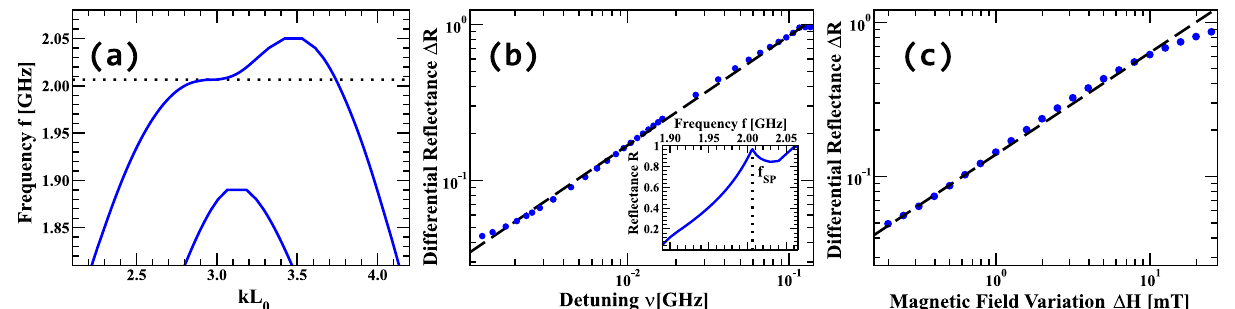
Fig. 2 Full wave simulations of the coupled microstrip waveguide platform. a The dispersion relation of this platform demonstrates a stationary in fl ection point frequency f SP which is shown by a dotted black line. b Logarithmic plot of the differential re fl ectance Δ R (blue dots) as a function of the frequency detuning ν from the non-resonant exceptional point degeneracy frequency f SP . The black dashed line indicates the best fi tting corresponding to a power law Δ R / ν j j 0 : 7 . The inset shows the formation of a cusp in the re fl ectance R spectrum, in the vicinity of f SP (vertical black dashed line). c Logarithmic plot of the differential re fl ectance Δ R (blue dots) as a function of the magnetic fi eld detuning Δ H from the applied magnetic fi eld strength H non-resonant exceptional point degeneracy occurs. The black dashed line is the best fi t Δ R / Δ H point of order m ¼ 3, can also apply for the stationary point of order m ¼ 2 (RBE) leading to a square root cusp i.e., Δ